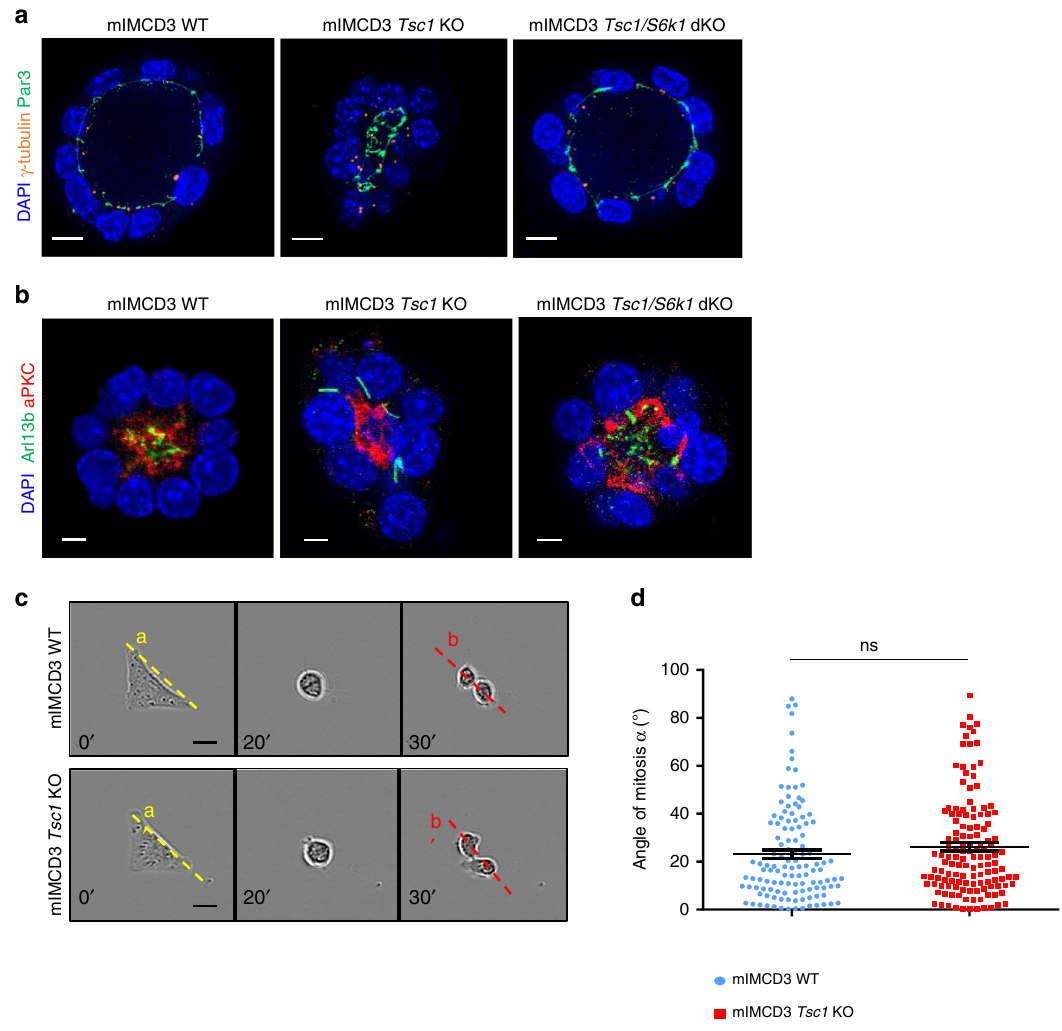
Fig. 5 Misoriented cell division and centrosome position in Tsc1 mutant cells is not due to intrinsic defects. a Representative images of 5-day mIMCD3s spheres immunolabelled with γ -tubulin, Par3 and DAPI to show the localization of the centrosomes compared to the apical markers. Scale bar, 10 µ m. b Representative images of 5-day mIMCD3s spheres immunolabelled with Arl13b, aPKC, and DAPI to show the localization of the primary cilia compared to the apical markers. Scale bar, 5 µ m. c Representative images of cells cultured on L shape patterns and recorded by time-lapse microscopy for the different genotypes. Scale bar, 20 µ m. d Distribution of mitotic spindle angles relative to pattern orientation ( α b − α a ) at anaphase onset. An average of 120 angles from three independent experiments were quanti fi ed for each genotype. Horizontal lines represent the mean ± SEM. Source data are provided as a Source Data fi